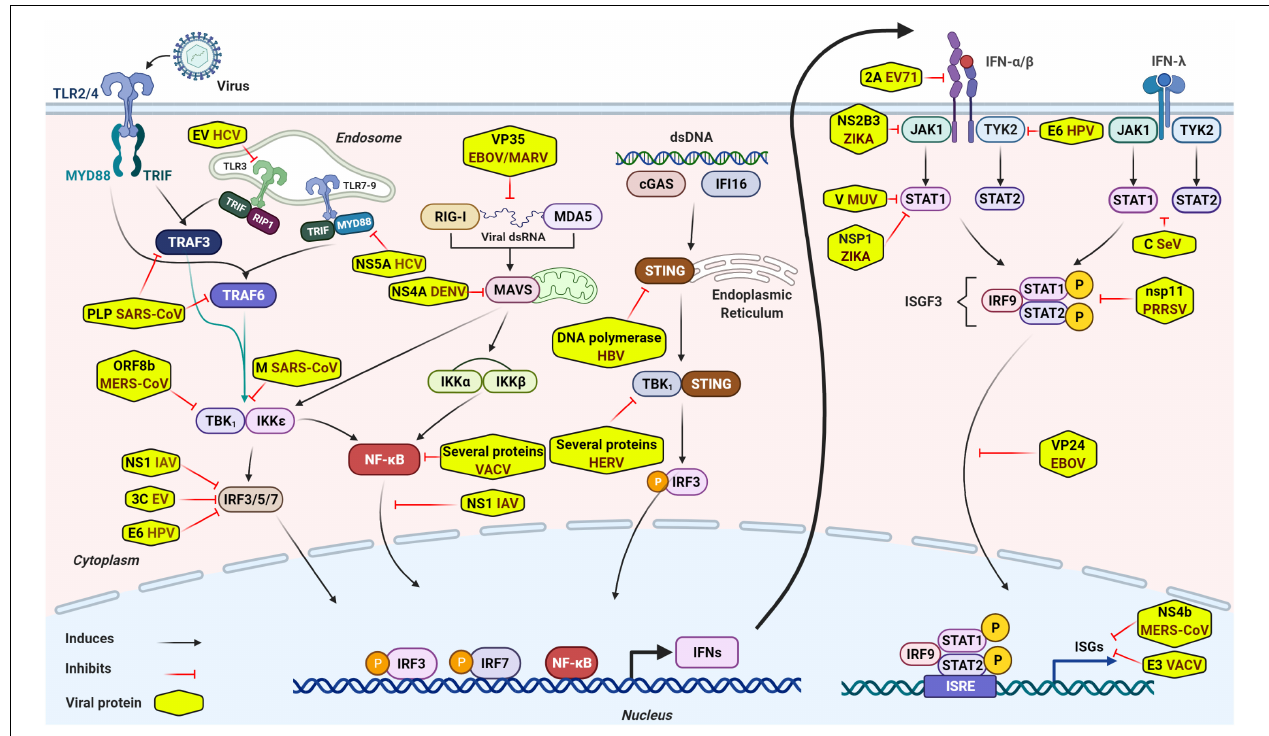
FIGURE 1 | General overview of intracellular innate immune signaling and some representative viral immune escape mechanisms. Sensing virus by PRRs initiates innate immune signaling through the hierarchical activation of PRRs family-specific adaptor proteins (TRIF, MAVS, STING, MYD88, and so forth) to activate transcriptional factors, such as IRF3/5/7, NF-kB, and others. Activated transcriptional factors translocate into nucleus and induce robust expression of IFNs. Secreted IFNs bind to their respective receptors and activate JAK-STAT signaling and form a transcriptional factor called ISGF3. ISGF3, then, translocates into nucleus to induce expression of numerous antiviral effectors (ISGs) to impede viral infection. Although antiviral innate immunity consists of well-equipped arsenals to impede viral infection and invasion, viruses circumvent or escape from these antiviral arsenals to establish successful infection through several mechanisms. Of these escape mechanisms, viral components inhibit innate immune signaling by diversified tactics, such as interacting directly or indirectly with crucial innate elements, targeting and cleaving adaptor proteins involved in innate immune signaling or interference of IFN signaling, degradation of JAK/STAT components, and so forth. Some representative viral immune escape tactics are shown in the Figure 1